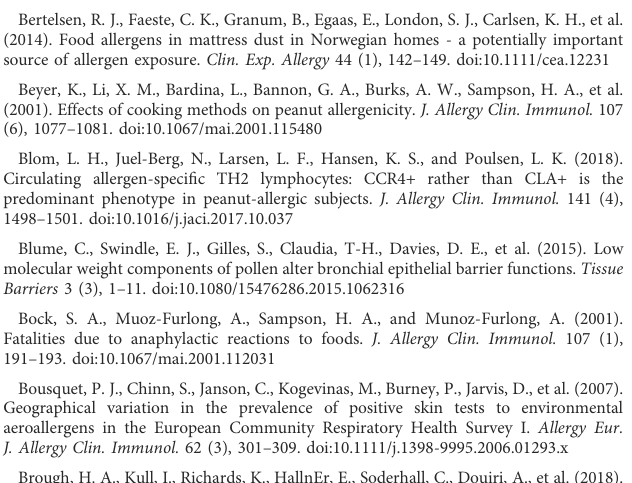
SUPPLEMENTARY FIGURE S1 TEER measurement in the presence of dextran. 16HBE14o- cell monolayers weretreatedapicallywithFITC-dextran(FD)ofdifferentsizes(4,10,or70 kDa) in the presence of allergens and/or PNL. H 2 O 2 and EGTA were used as positive controls. TEER was monitored at 2, 6, and 16 h following treatment. The TEER of unstimulated cells treated with each FD (control) was used as a baseline and is showed by a dashed line. Data shown are the mean ± SD of three independent experiments. SUPPLEMENTARY FIGURE S2 Paracellular permeability assay. Transport of FD4, FD10, or FD70 through the cell monolayer, in presence of EGTA and H 2 O 2 . Data (mean ± SD of three experiments) show levels of FD after 2, 6, and 16 h of apical exposure. SUPPLEMENTARY FIGURE S3 Cytokines release upon stimulation with Ara h 2 with and without PNL. Cell monolayers were treated apically with Ara h 2 ± PNL, and the concentrations of CCL2, IL-6, and IL-8 released into the basolateral medium were measured after 16 h. SUPPLEMENTARY FIGURE S4 Synthetic lipids do not affect TEER measurements. Glyceryl trioleate and oleic acid wereaddedapically to 16HBE14o-cells andtheTEER wasmeasuredafter 2, 6, and 16 h of treatment. Results are expressed as the percentage of the TEER measured in untreated cells (dashed line). Data represent the mean ± SD of two experiments. SUPPLEMENTARY FIGURE S5 1 H-NMR spectra of roasted (above), raw (middle), and boiled (below) peanut lipids. Black arrows highlight major differences in the